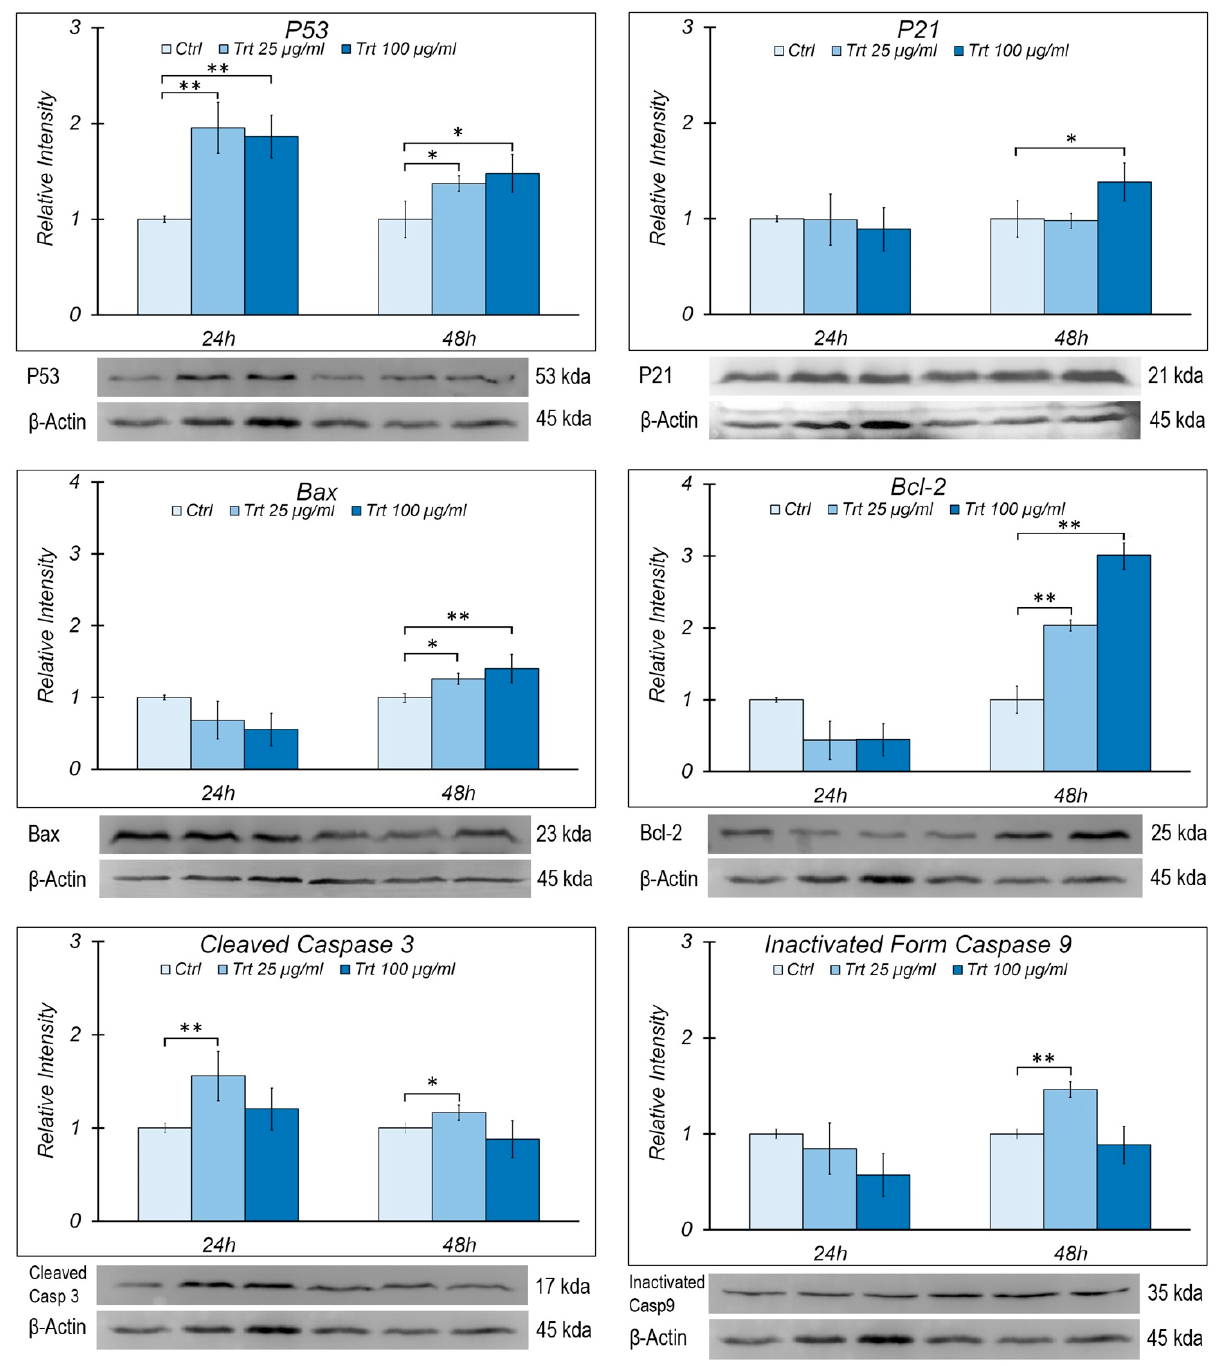
Figure 4. Western blots analysis of protein levels of p53, p21, Bax, Bcl-2, cleaved caspase 3, and inactive form of caspase 9 in RAW cells, treated (Trt) or untreated (Ctrl) for 24 or 48 h with 25 or 100 μ g/mL of passenger tire wear particles. Histograms showing the relative intensity of the Western blot bands of these proteins along with the representative Western blots are shown. The densitometry values were normalized for β -actin and were compared with the control. The means ± S.E.M. are reported (n = 3). Student’s t test was employed to compare the values of the treated and non-treated cells. * p < 0.05; ** p <